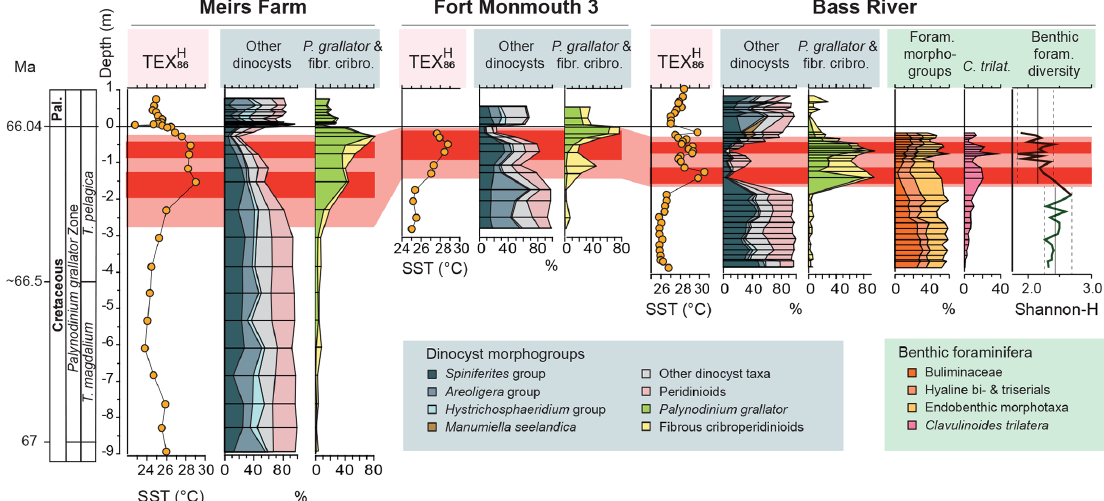
Figure 2. Relative abundances of dinocyst and benthic foraminiferal morphological groups and TEX 86 SST records of Bass River, Meirs Farm and Fort Monmouth 3. TEX 86 data of Meirs Farm and Fort Monmouth 3 are from Vellekoop et al. (2016); TEX 86 data of Bass River are from Woelders et al. (2018). Depth in meters distance from the K–Pg boundary. The latest Maastrichtian warming interval is indicated in pink and red, with red marking peak warmth. For the stratigraphy and age models, see Text S2 – Age Model; for the raw data, see Tables S1– S6. Foraminiferal morphogroups are cumulative. In these foraminiferal morphogroups, Clavulinoides trilatera is included in the endobenthic morphotypes. The total variation and average benthic foraminiferal diversity values are indicated for the prewarming and warming intervals. Pal. – Paleogene; T. pelagica – Thalassiphora pelagica ; T. magdalium – Tanyosphaeridium magdalium ; C. trilat. – Clavulinoides trilatera